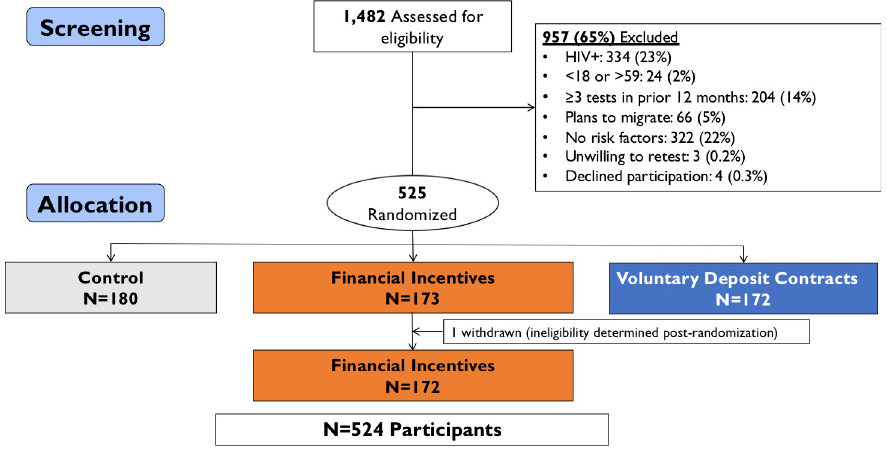
Fig 2. Participant flowchart indicating screening, randomization, and allocation to study group in a randomized controlled trial of financial incentives and deposit contracts to promote HIV retesting in Uganda.